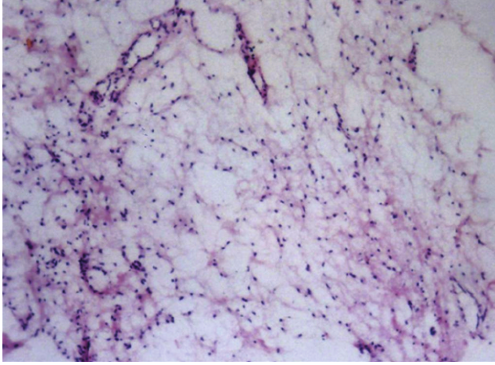
Figure 5: Microphotograph showing mixed area of fibrous tissue and inconspicuous stands of odontogenic epithelium in a myxoid stroma; magnification: × 40.